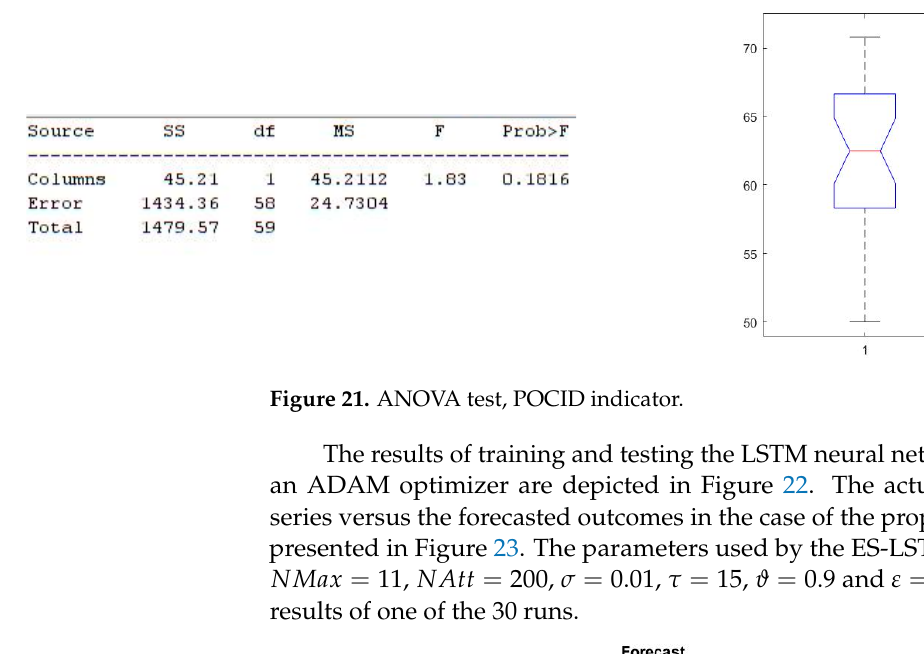
ues, but the one corresponding to the proposed method is slightly better.